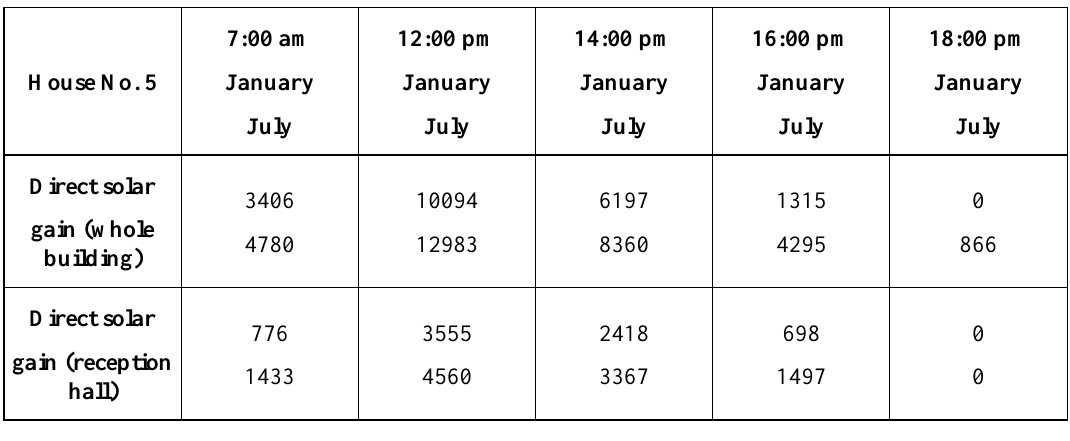
Table 9 Direct solar gain of house No.5 (unit: W.h) (Data done in Ecotect, Source: Author)